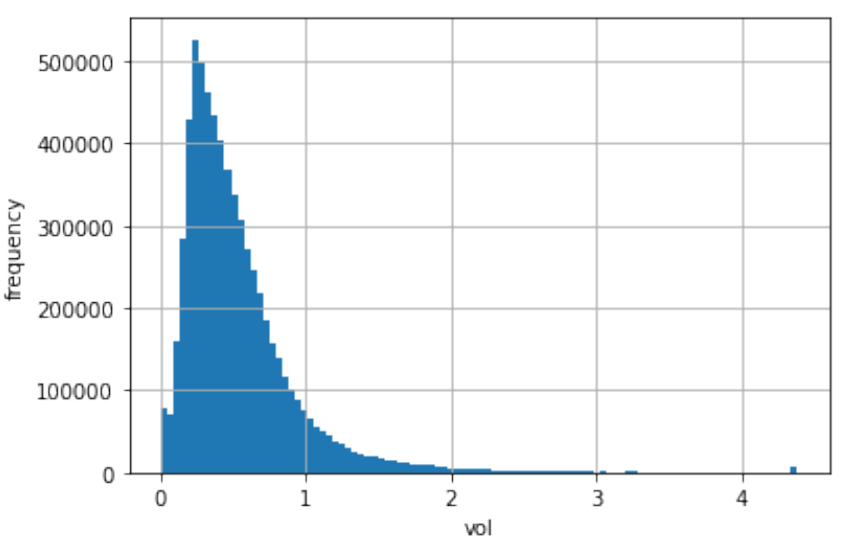
Figure 1. Histogram of the volatility of all stocks in the period 2008–2020. Scheme 2 shows the volatility co-movement for stocks of similar volatility averaged over the whole period without subtracting, and subtracting, the market (upper panel and lower panel, respectively). For this purpose, stocks are classified according to the volatility in bins of width 0.10, and the summation in the calculation in C 3 t ( 20 ) is restricted to stocks within the same